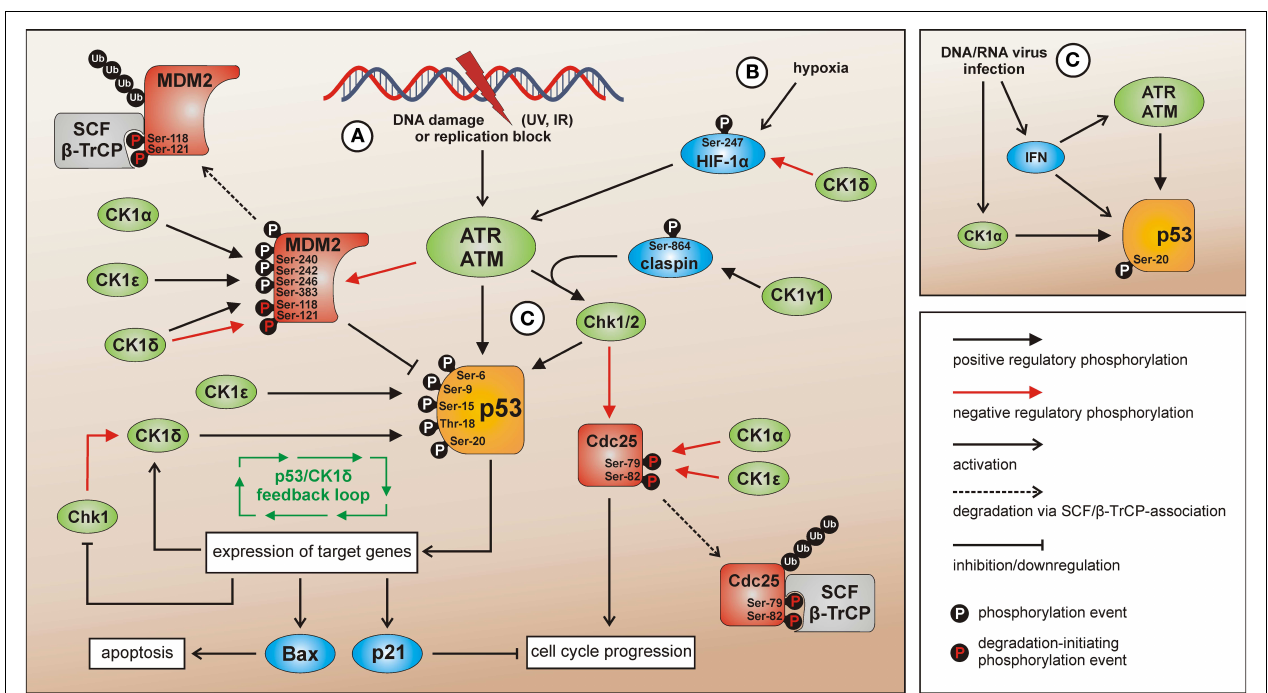
or ε leading to enhanced binding of MDM2 to p53. CK1 δ -mediated phosphorylation of Ser-118 and Ser-121 however marks MDM2 for proteasomal degradation (155, 239–241). In case Chk1/2 gets activated after DNA damage the phosphatase Cdc25, normally initiating cell cycle progression, is blocked by inhibitory phosphorylation and subsequent degradation. In the regulation of Cdc25 inhibition and degradation also CK1 isoforms α and ε are involved (141, 143). Signaling mediated by p53 can also be initiated by hypoxia (via CK1 δ -regulated HIF-1 α ; situation B) (216, 243, 244) or DNA/RNA virus infection (via IFN and/or CK1 α -related signal transduction; situation C) (236, 245). Depicted phosphorylation events refer to reported CK1-specific target